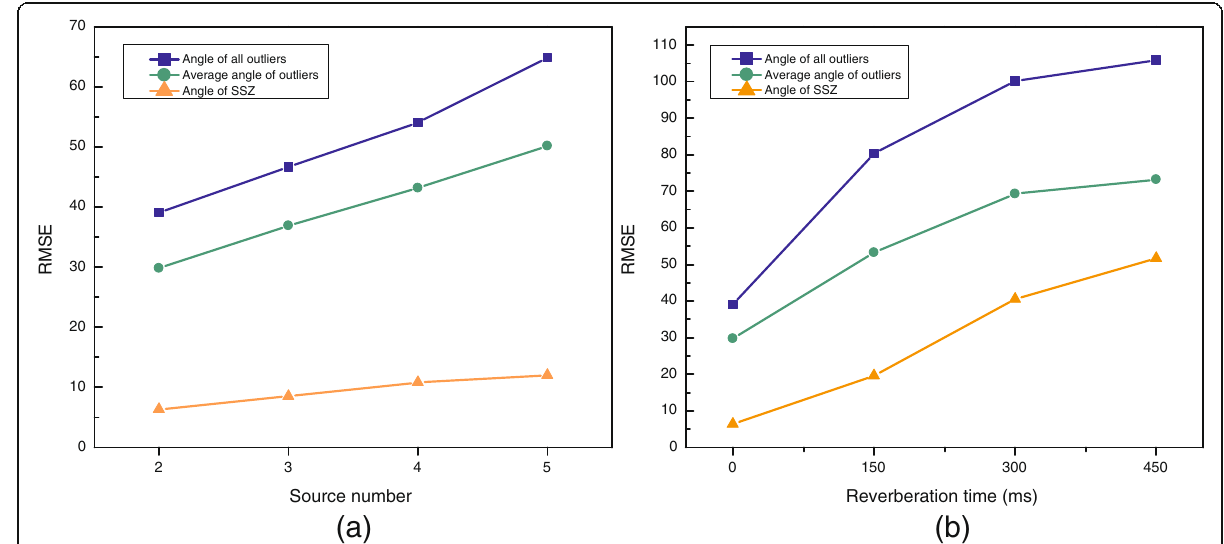
Fig. 2 Different methods to obtain azimuth and their corresponding RMSE. a Different source number in anechoic room ( b ) two sources with different reverberation